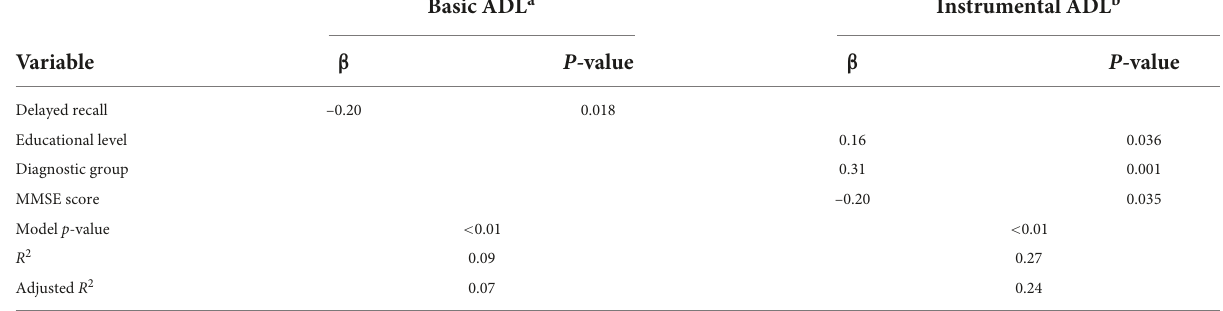
TABLE 5 Regression models with predictors for ADL